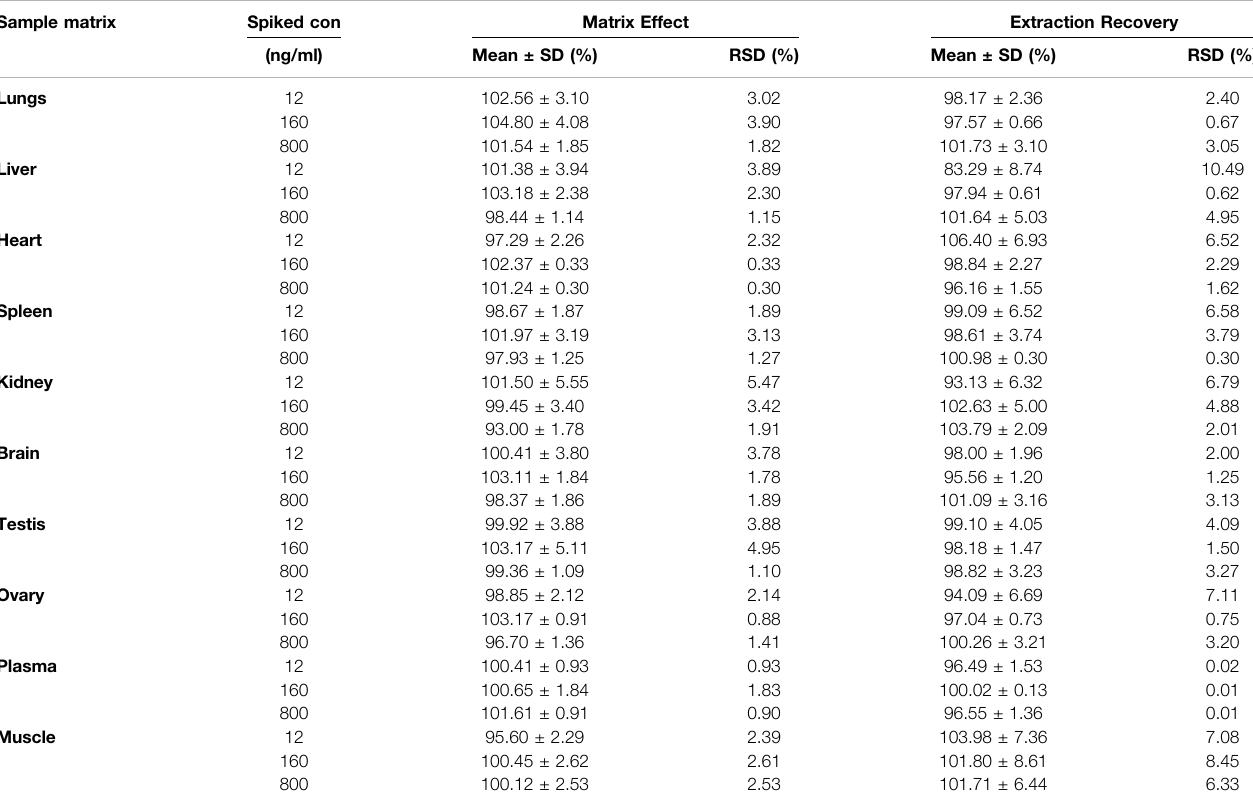
TABLE 3 | Matrix effect and extraction recovery of amento fl avone in rat tissue homogenates (n = 5). Sample